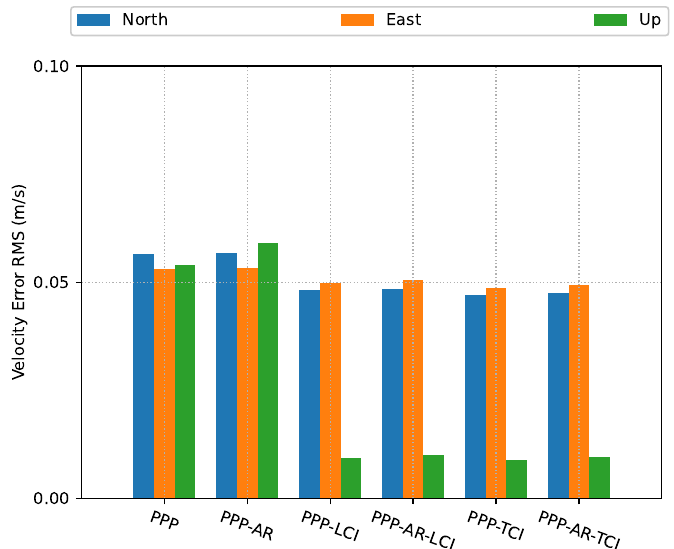
Figure 11. PPP/INS positioning velocity error RMS of the train test on 7 March 2022. The heading direction in Figure 12 shows frequent spikes because the heading angles of the train included dramatic changes in the movement along the curved path, and the interpolated results were also affected, as compared to the reference. The accurate heading determination required additional alignment for this PPP/INS system. The roll and pitch errors were below 0.1 ◦ , as shown in Figure 13.